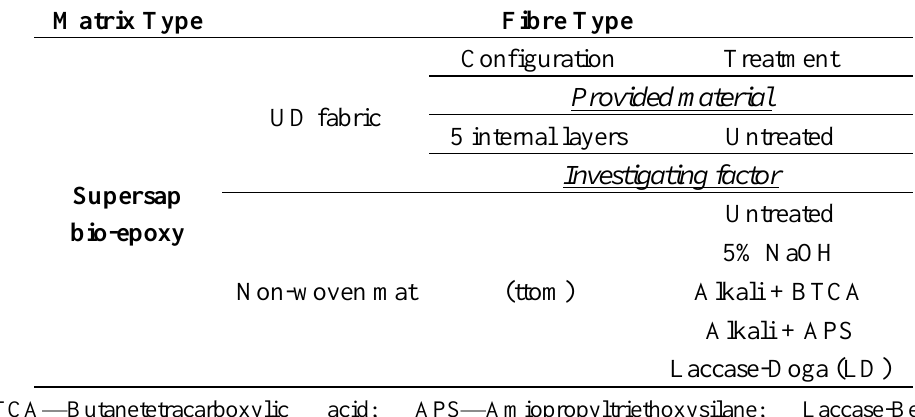
Table 3. The hybrid flax reinforced bio-epoxy composites with